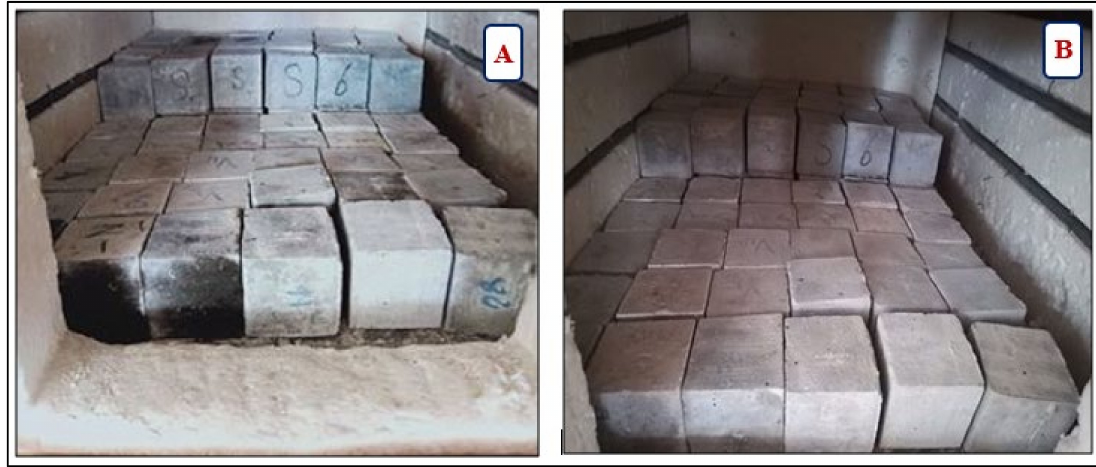
Figure 10. Concrete samples before ( A ) and after ( B ) 500 ◦ C fire exposure.